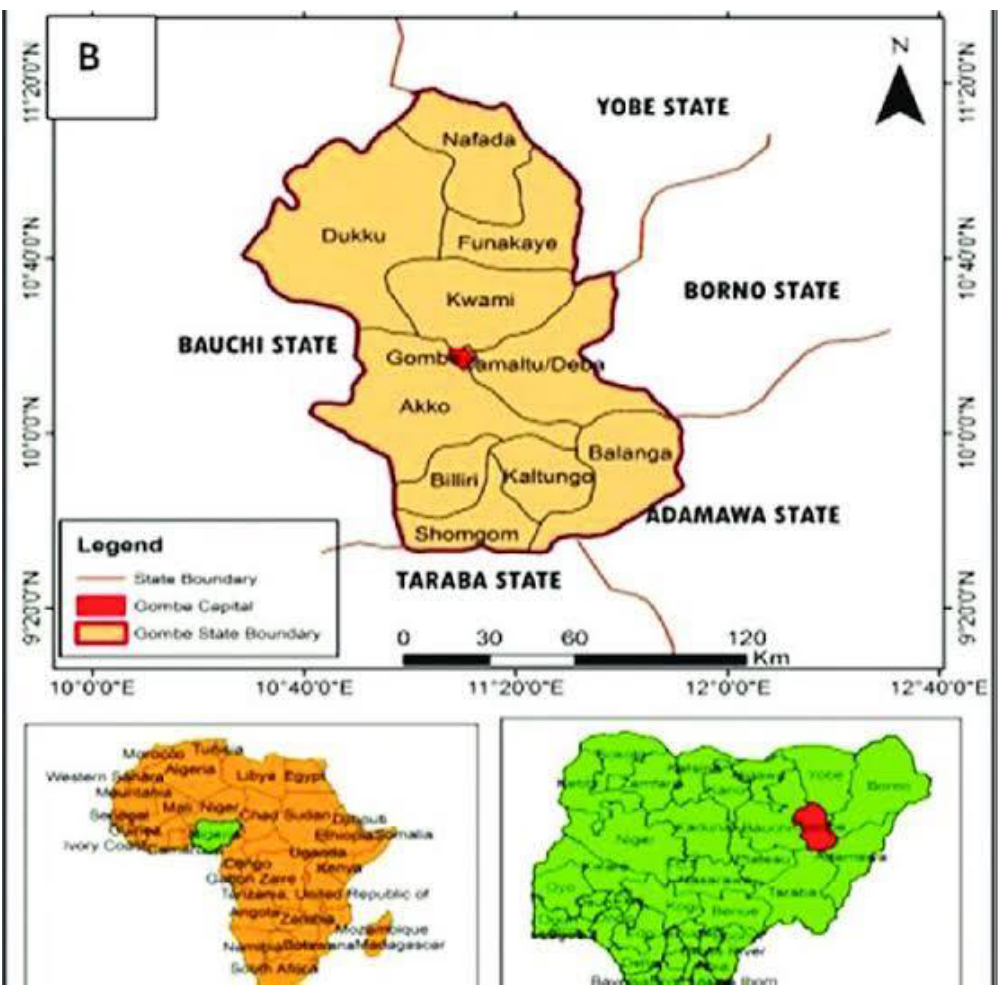
Figure 1: Map of Gombe state, Nigeria